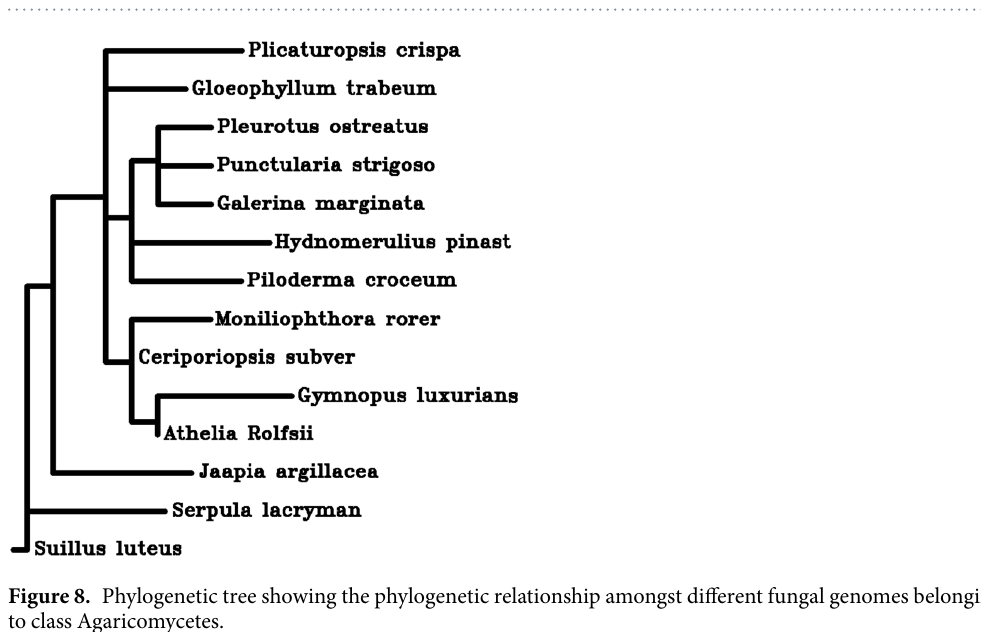
Figure 7. Depicted the distribution of Cazy families into A.rolfsii secretome (inner circle) and whole proteome (outer circle). GH: Glycoside Hydrolases, GT: Glycosyl Transferases, PL: Polysaccharide Lyases, CE: Carbohydrate Esterases, CBM: Carbohydrate-Binding Modules, and AA: Auxillary Activities.